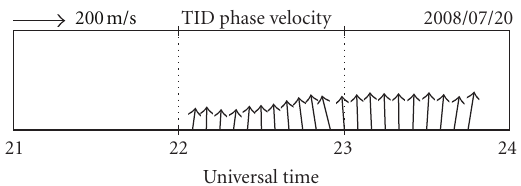
Figure 7: Phase velocity of the TIDs calculated using the CCM method and based on the data collected by the small array that oper- ated near